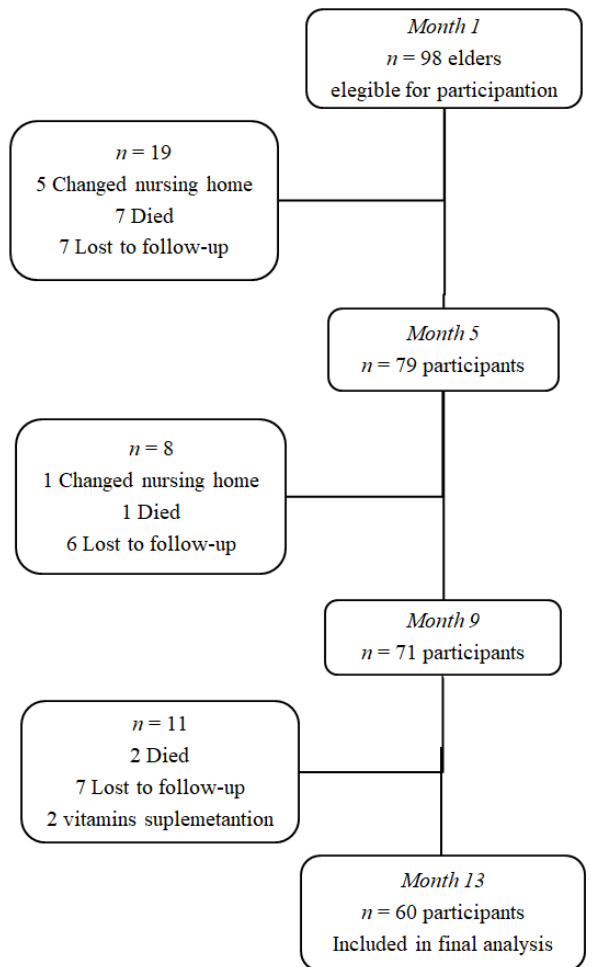
Figure 1. Flow chart of participants in the study. Table 1. Baseline characteristics of the study population ( n = 60) ¹.